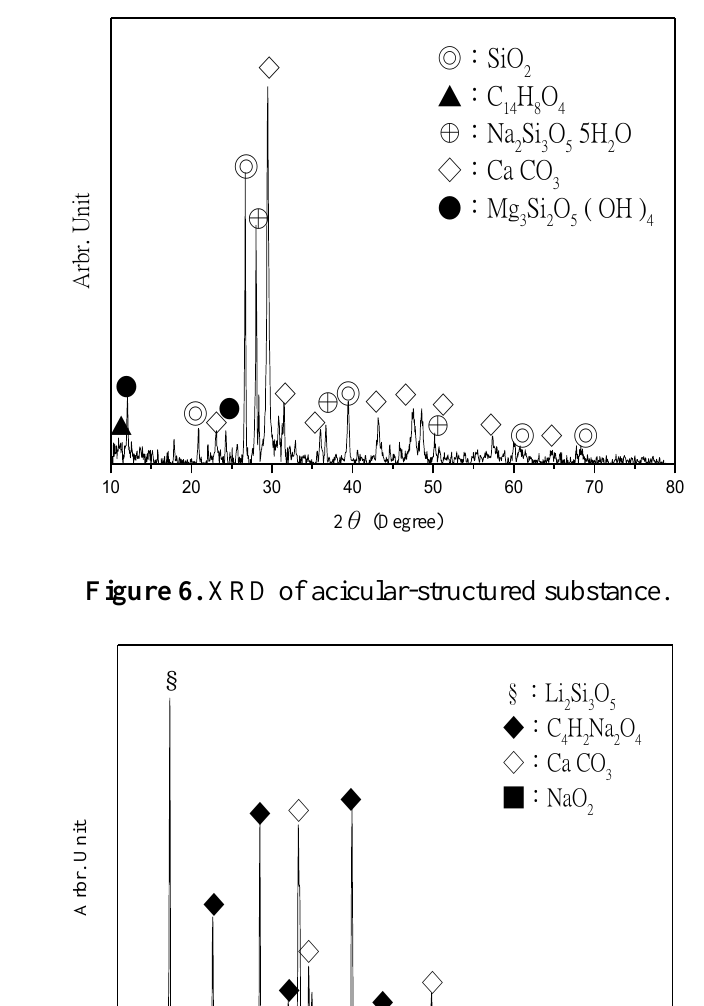
Figure 5. XRD of crystalline penetration sealer materials (CPSM)’s topping.